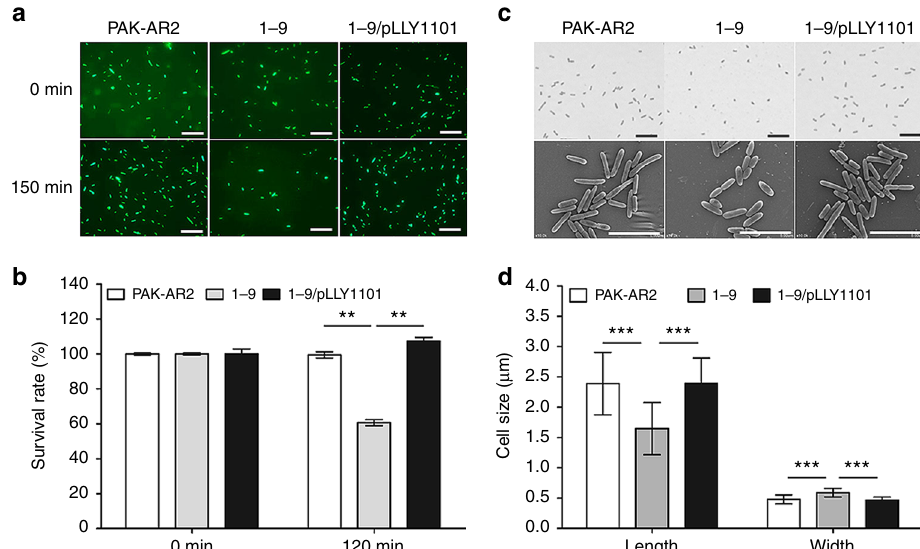
Fig. 7 In fl uence of SrpA on T6SS activity and cell shape. a Fluorescent microscopy images of E. coli DH5 α carrying the gfp gene incubated with the indicated P. aeruginosa strains. The scale bars represent 10 μ m. b Enumeration of viable E. coli cells using fl ow cytometry (lower panel). c Gram-stained bacterial cells of the indicated strains and the scale bars represent 10 μ m (upper panel). SEM images of the indicated cells and the scale bars represent 5 μ m (lower panel). d Measurements of cell dimensions (40 cells per strain, lower panel). The experiments were independently replicated three times. One-way ANOVA was used to examine the mean differences between the data groups. ** P < 0.01. *** P < 0.001. Error bars show standard